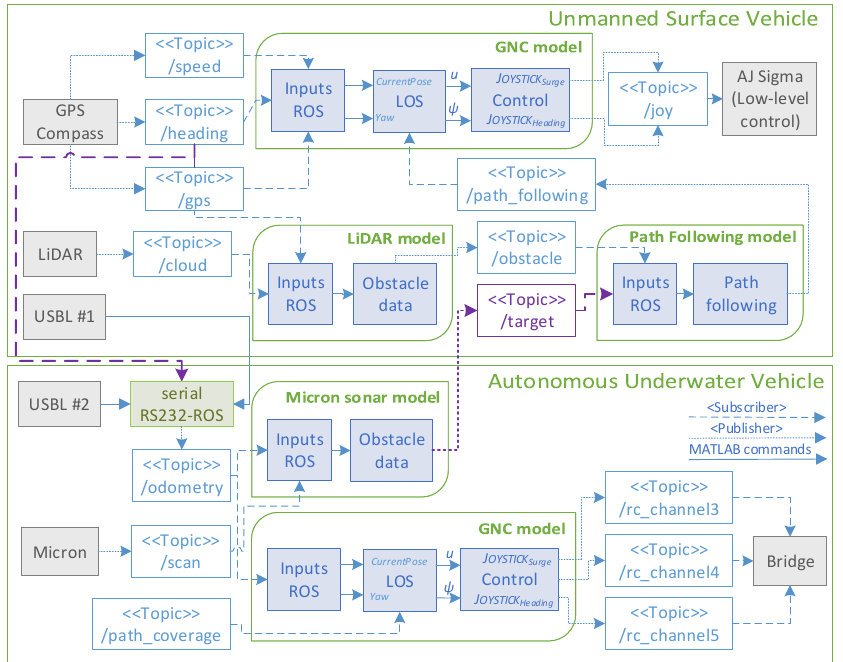
Figure 13. Schematic of the modular multi-vehicle guidance system with target detection. All different modules from USV and autonomous underwater vehicle (AUV) were included. ROS topics / gps , / heading and / target (purple connectors) are the exchange topics in the control